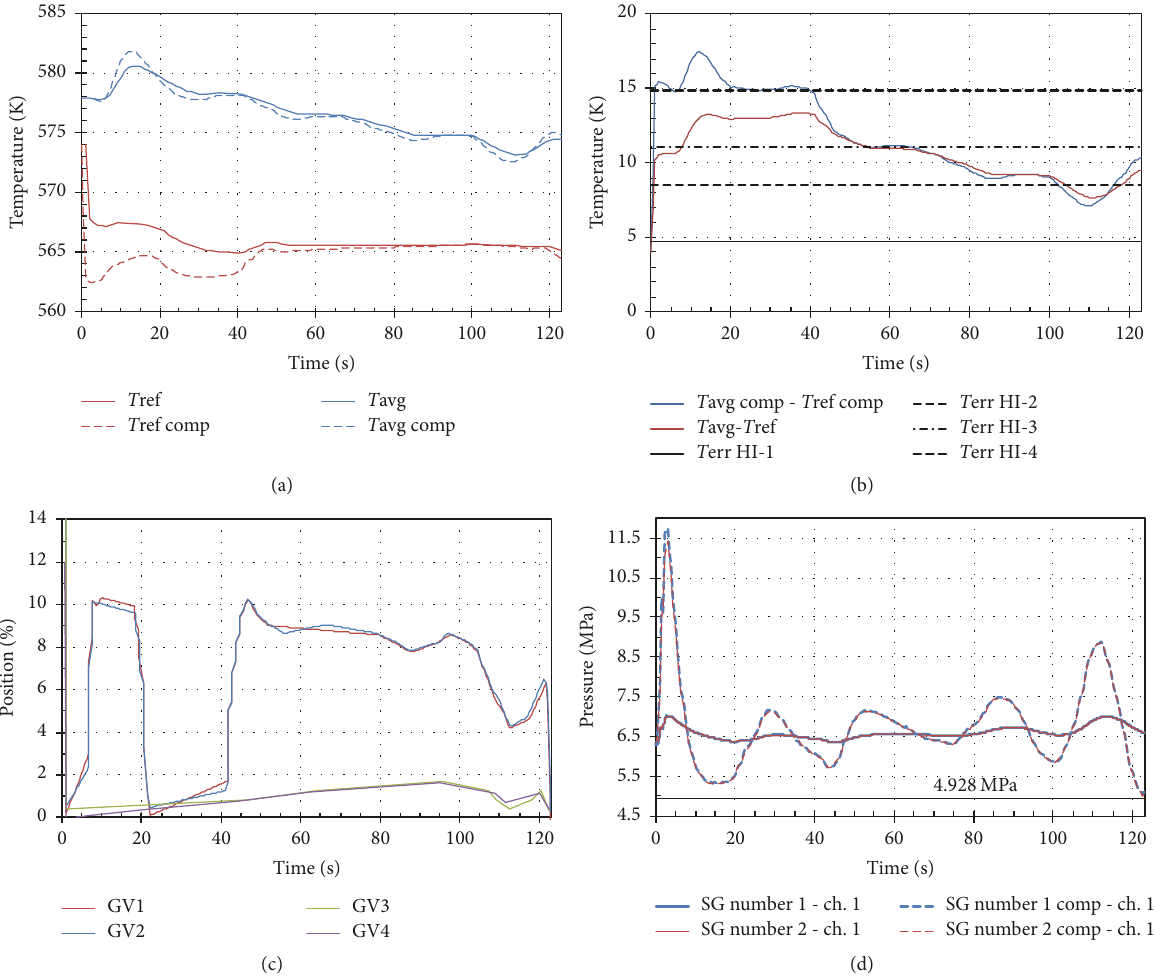
Figure 6: (a) Measured RCS average and reference temperature signal and the corresponding compensated signals; (b) measured error temperature signal for steam dump demand and the corresponding difference signal between RCS average and reference temperature; (c) turbine governor valve position indications; (d) steam generators pressures and compensated low steam line